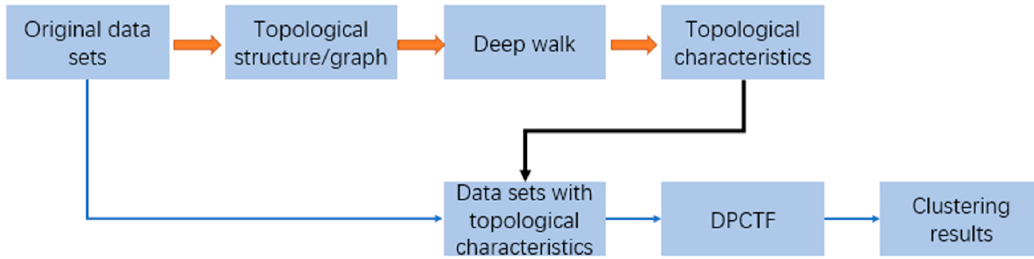
Figure 5. Density Peak Clustering Algorithm Considering Topological Features (DPCTF) algorithm flowchart. The first step of the algorithm is the rough arrow flow. The thin arrow is the second step of the process, combining the original data with topological characteristics, and finally clustering results are obtained by Clustering by Fast Search and Find of Density Peaks (CFSFDP) algorithm.